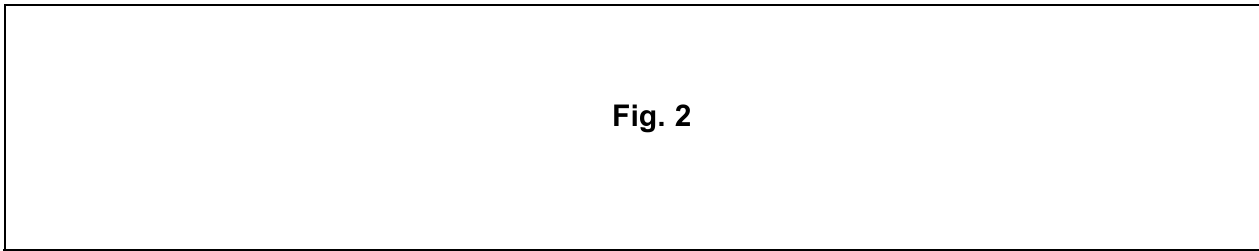
Fig.2 : Primer design and expected amplification fragment with location of the polymorphism sites (-1654; -1641 & -1476